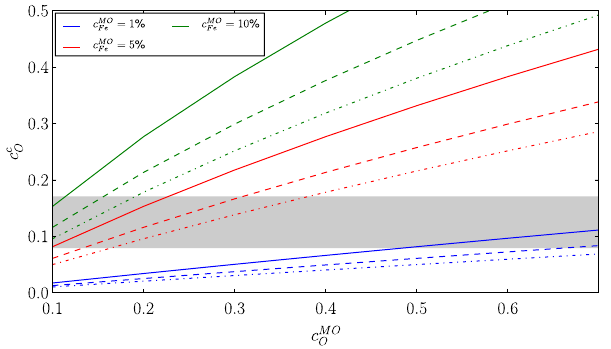
FIG. 3. Predicted equilibrium concentration of oxygen in liquid metal c c as a function of oxygen and iron concentrations in O silicate melt c MO and c MO , respectively. Line styles denote Fe O different temperatures: T ¼ 5000 K (solid), 5500 K (dashed), and 5000 K (dot-dashed). The gray shaded region highlights the range of oxygen concentrations estimated for the present-day core